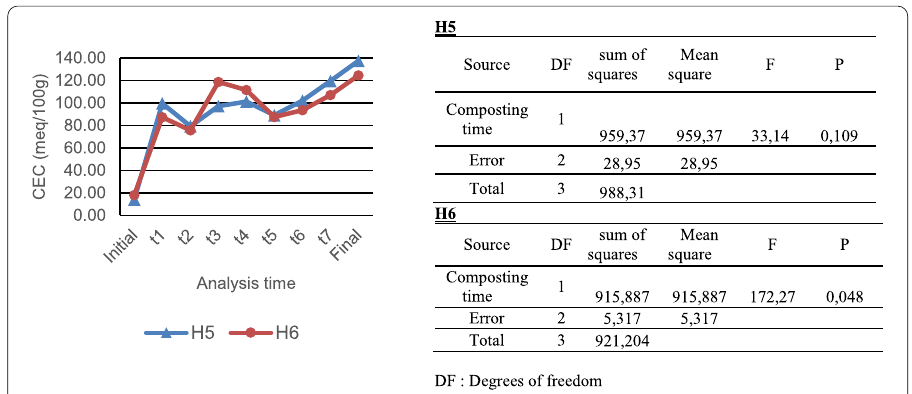
Fig. 11 CEC evolution during co‑composting of TM and OP (left) and ANOVA test associated (right)